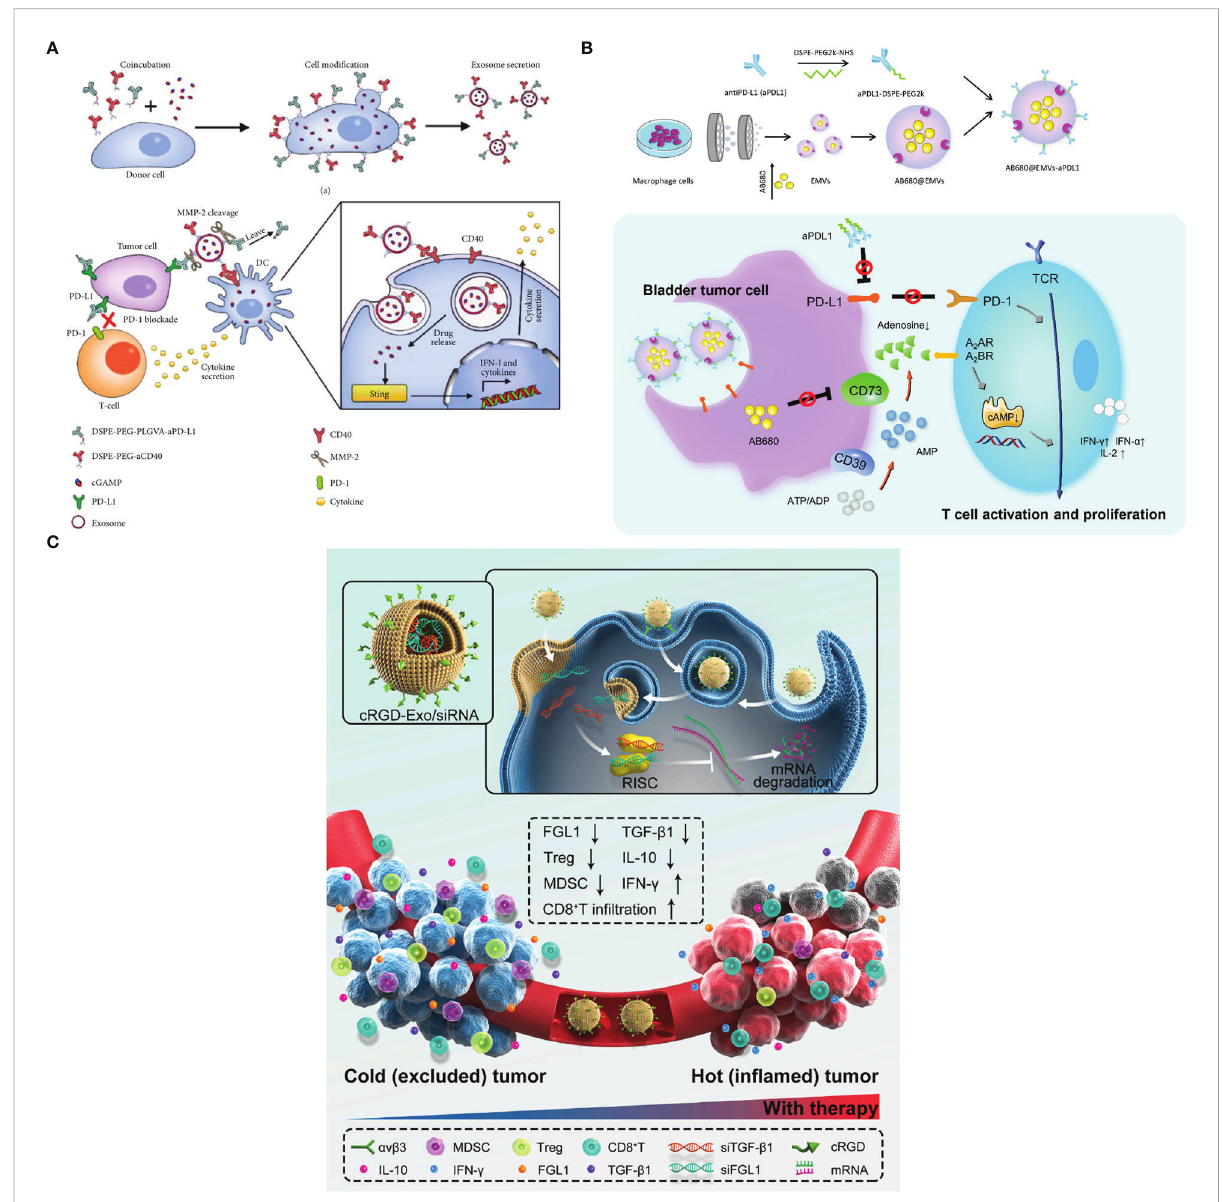
FIGURE 5 (A) The fabricated scheme of cGAMP@dual-anti-Exos and the process of cancer immunotherapy (Reprinted with the permission from Ref. 137). (B) The scheme of AB680@EMVs-aPDL1 for bladder cancer therapy (Reprinted with the permission from Ref. 153). (C) The mechanism of cRGD-Exo/siMix for colorectal cancer immunotherapy in vivo (Reprinted with the permission from Ref. 154). PD-1; Programmed cell death protein 1, PD-L1; Programmed cell death ligand; MMP-2; Matrix metalloproteinase enzyme; cGAMP; 2 ’ -3 ’ -cyclic guanosine monophosphate – adenosine monophosphate; AB680; CD73 inhibitor, EMVs; Exosome-mimetic nanovesicles, aPDL1; Monoclonal antibody targeting programmed cell death ligand 1; cRGD-Exo/siMix; a cyclic RGD peptide (cRGD)-modi fi ed exosome delivery system that simultaneously delivered FGL1 and TGF b 1